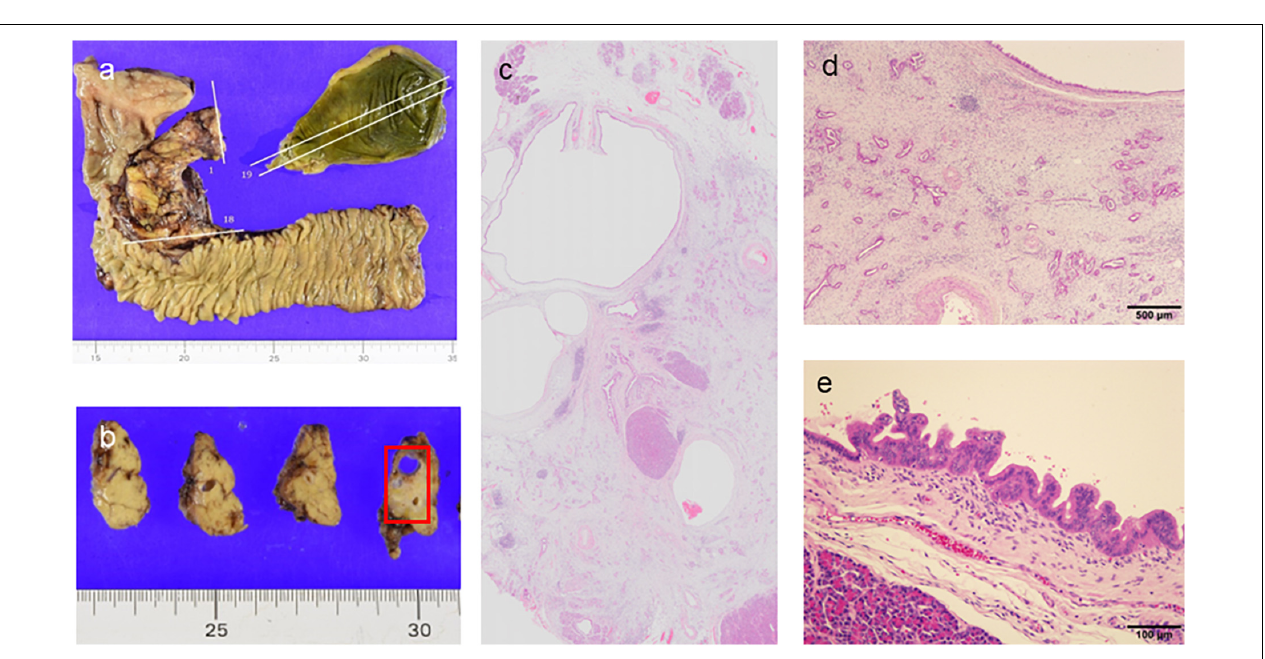
FIGURE 4 | Magnetic resonance imaging findings of the presented case. (A) Magnetic resonance cholangiopancreatography (MRCP) shows disruption of the main pancreatic duct (MPD) (arrowhead) and a nearby cyst. (B) T1-weighted fat saturation MRI shows necking of pancreas parenchyma (arrowhead) with weak low-intensity change in a pancreatic body. (C) T2-weighted MRI shows dilated pancreatic duct and nearby cyst (arrowhead). (D) Diffusion-weighted MRI ( b = 1,000) shows no sign of malignancy.